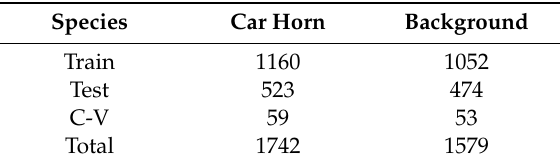
Table 7. Next, we compressed the data of the dataset by the ADPCM method, and the compressed dataset occupies the capacity of 116 M. We used the compressed dataset to test again with the same conditions, and the recognition result is shown in Table 8. Table 6. The number of samples in our dataset.